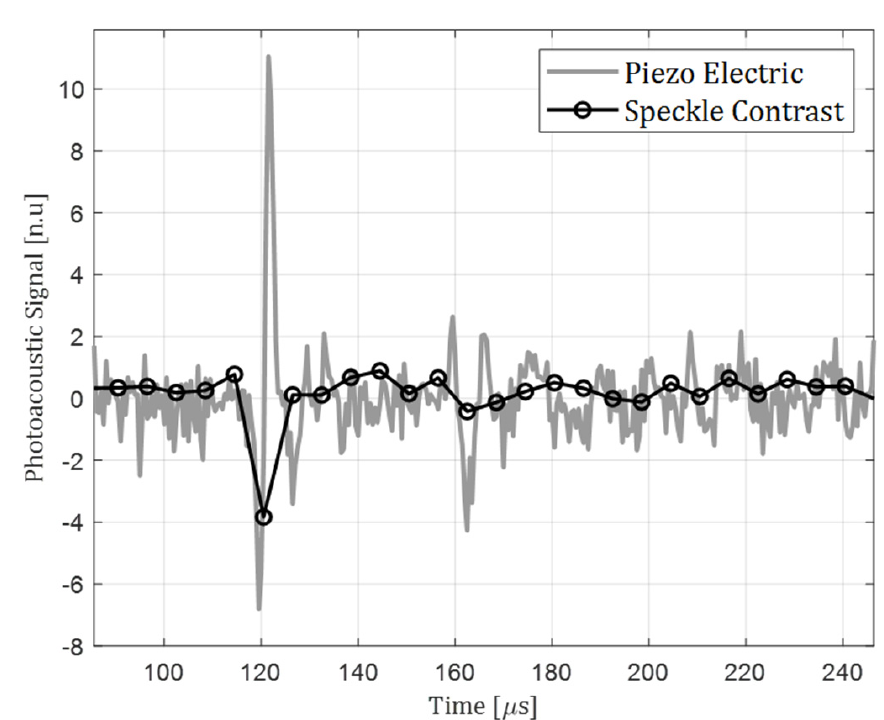
Figure 4. Photoacoustic signal reconstruction-compared to piezo electric transducer.